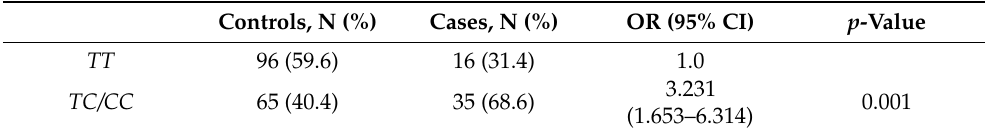
Table 7. Distribution of CYP19A1 codon 39 polymorphisms in women with tubal pathologies and controls (fertile women).